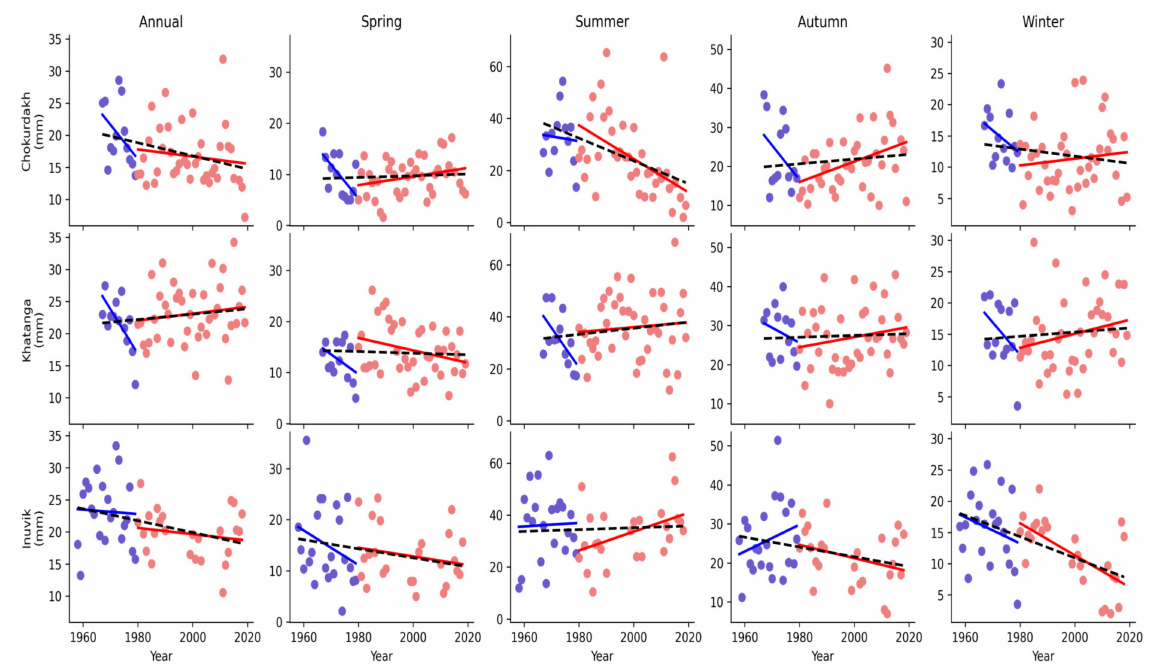
Figure 3. Annual, spring, summer, autumn and winter precipitation data were obtained from the local meteo.ru database for Chokurdakh (YAK) and Khatanga (TAY), while they were obtained from climate.weather.gc.ca, Accessed on 30 August 2021 for Inuvik (CAN),